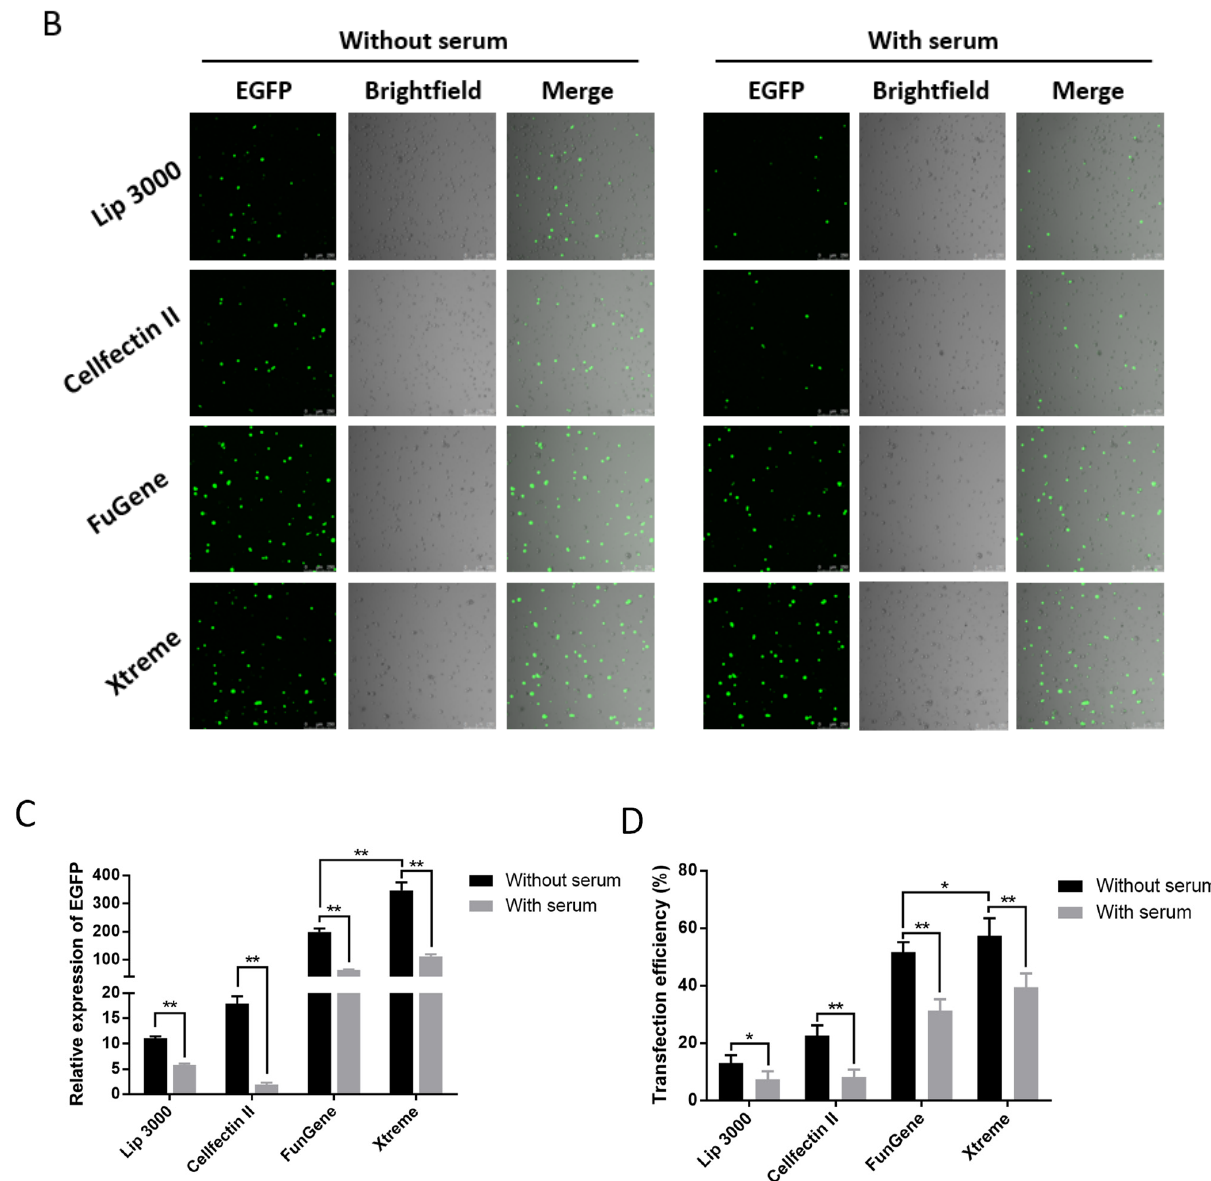
Figure 1. Transfection efficiency of different transfection reagents with serum and without serum. ( A ) Schematic diagram of the workflow with and without serum during transfection. The red in the 24-well plate indicates that the medium contains serum, and the blue indicates that only Grace’s Insect Cell Culture Medium (Grace medium) is present. ( B ) Fluorescence image of cells after transfection. Photographed by laser confocal, exposure time and excitation light intensity are consistent during shooting. ( C ) The relative expression of EGFP under different treatments. The reference gene is RPL32 of P. xylostella , ** indicates highly significant (Duncan, p < 0.01). ( D ) The efficiency of cell transfection under different treatments. * indicates significant difference (Duncan, p < 0.05), ** indicates highly significant difference (Duncan, p < 0.01).